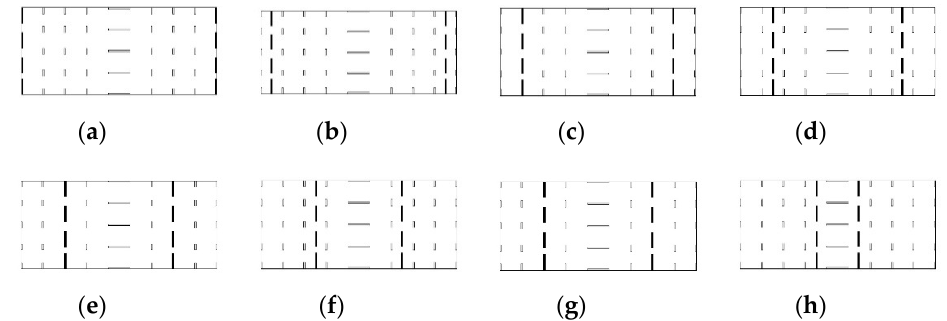
Figure 3. Building plans for second group of parametric study (with b/r = 1.4): ( a ) Building frequency ratio Ω = 1.4; ( b ) Building frequency ratio Ω = 1.3; ( c ) Building frequency ratio Ω = 1.2; ( d ) Building frequency ratio Ω = 1.1; ( e ) Building frequency ratio Ω = 1.0; ( f ) Building frequency ratio Ω = 0.9; ( g ) Building frequency ratio Ω = 0.8; ( h ) Building frequency ratio Ω = 0.7.